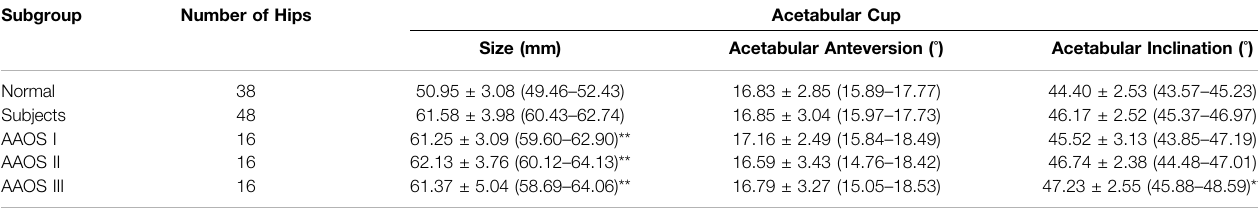
TABLE 2 | The size and position parameters of implanted acetabular cups in 3-Dimensional environment.